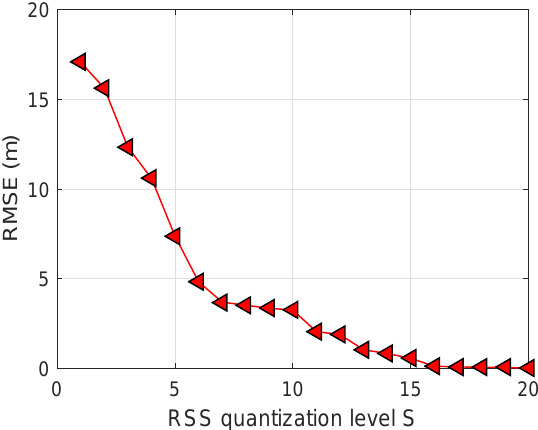
Figure 4. Impact of RSS quantization levels on root mean squared error